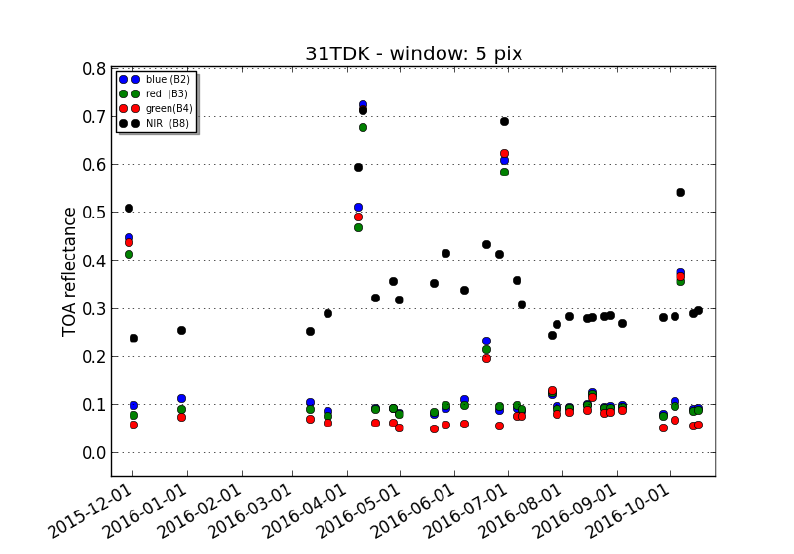
Figure 1. Time series of top of atmosphere reflectances from the Sentinel-2 Level 1C product, regardless of cloud cover, for a mid-altitude meadow in the center of France, for four spectral bands centered at 490 nm (blue dots), 560 nm (green dots), 670 nm (red dots), and 860 nm (black dots).